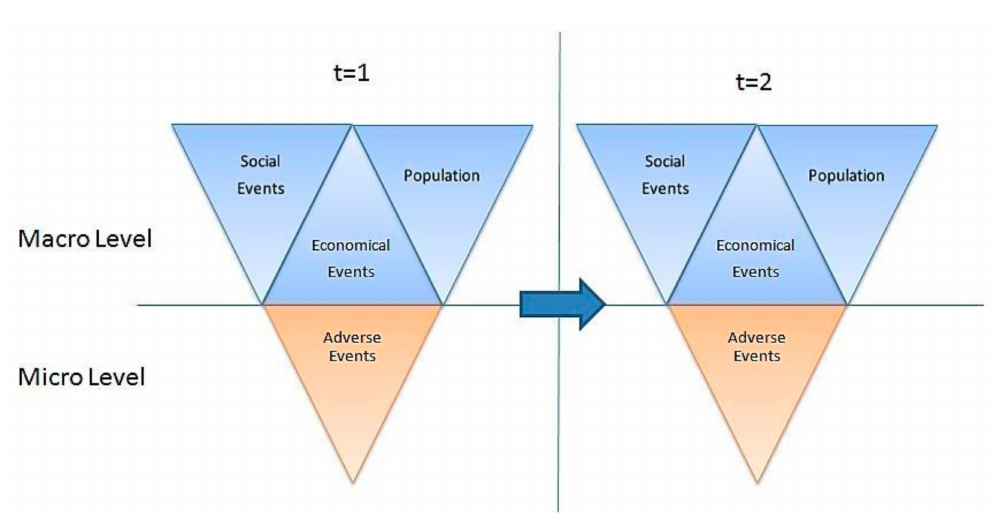
Figure 1. Cellular automata framework.